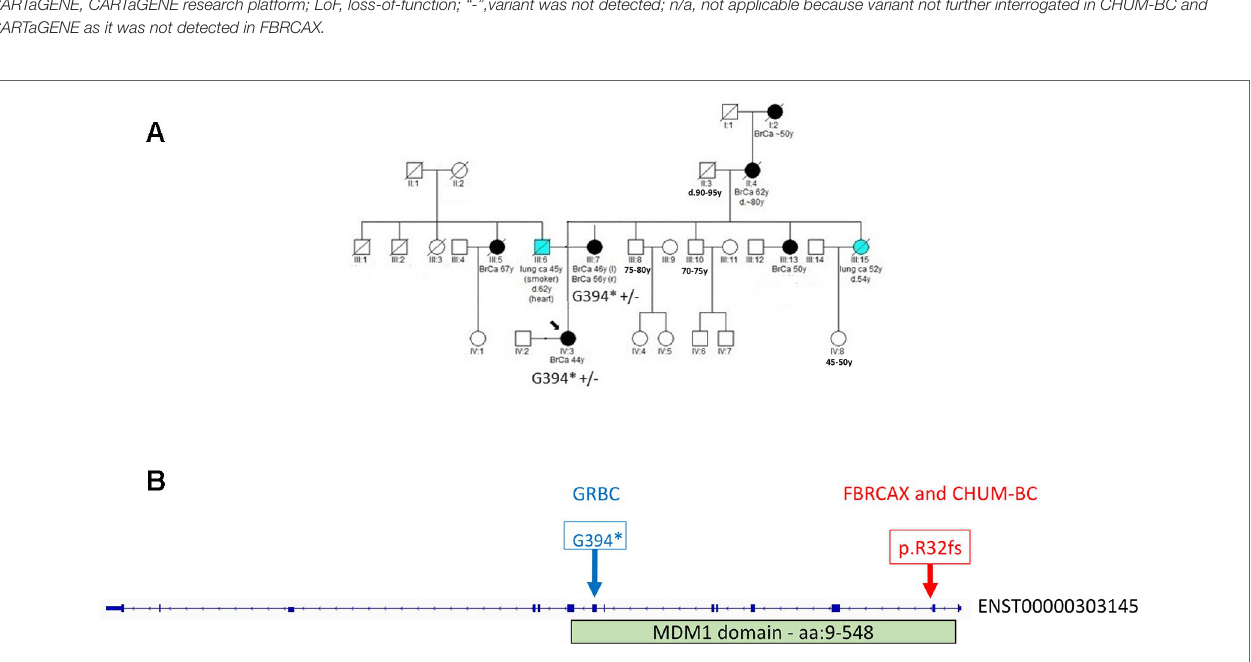
FIGURE 3 | (a) Segregation of MDM1 :G394* in GRBC pedigree F25. Both mother (diagnosed with bilateral BC at 46 and 56 years of age) and daughter (diagnosed with BC at 44 years of age) were heterozygous carriers of the MDM1 stop-gain variant. (B) Genomic positions of MDM1 LoF variants detected in Greek (GRBC, MDM1 :G394*) and French Canadian (FBRCAX and CHUM-BC, MDM1 :p.R32fs) patients. Variants were experimentally validated using Ampliseq (GRBC) and Sanger sequencing (FBRCAX). CHUM-BC variants were detected using the iPLEX MassARRAY.